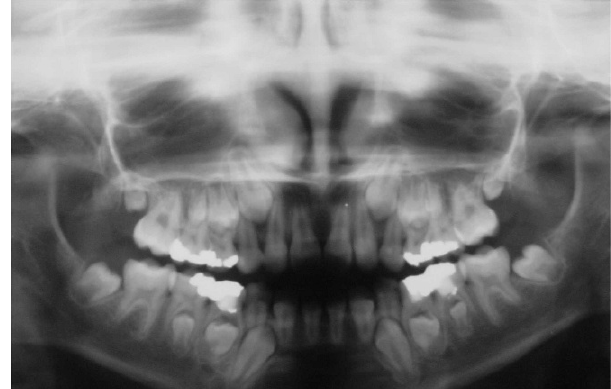
Figure 1 - Panoramic radiograph of a 2-year-old patient at diagnosis who was submitted to chemotherapy and 1,800 cGy irradiation. Note microdontia of the lower left premolars and second permanent molar.